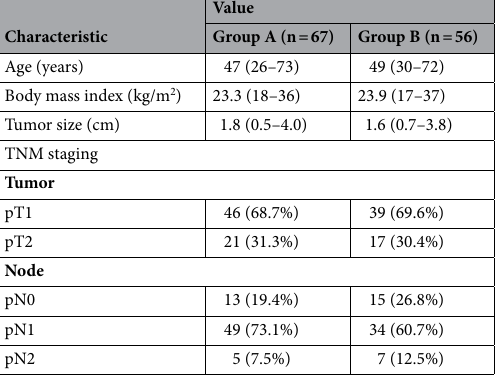
Table 1. Clinical characteristic of the patients enrolled in this study. TNM staging, Tumor, node and metastasis staging.